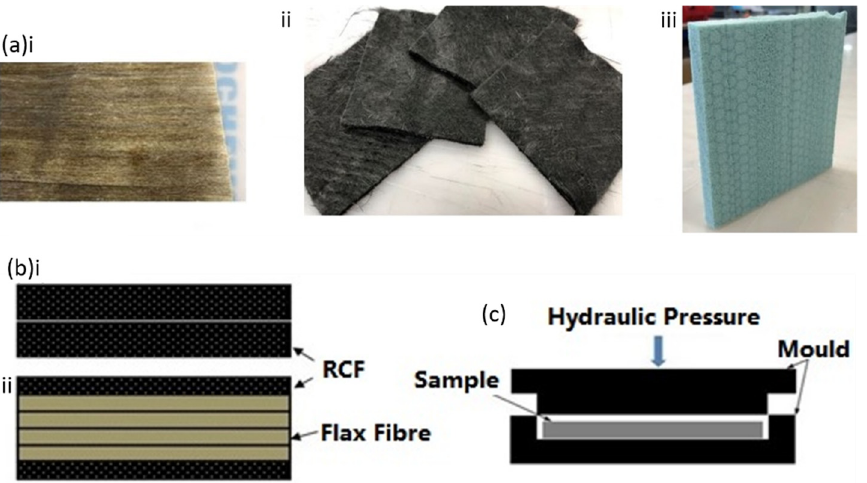
Figure 1. ( a ) Materials: (i) flax fibers; (ii) recycled carbon fiber mat; (iii) recycled PET foam; ( b ) skin configurations: (i) recycled carbon fiber (RCF) skin (S1); (ii) hybrid skin of RCF/Flax fibers (S2); ( c ) compression molding.